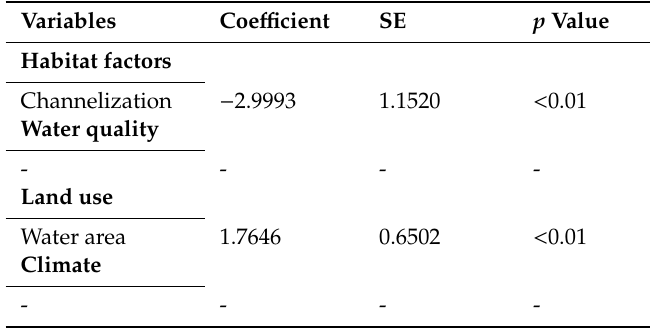
Table 3. Associations between environmental variables and the presence of non-native fish species.